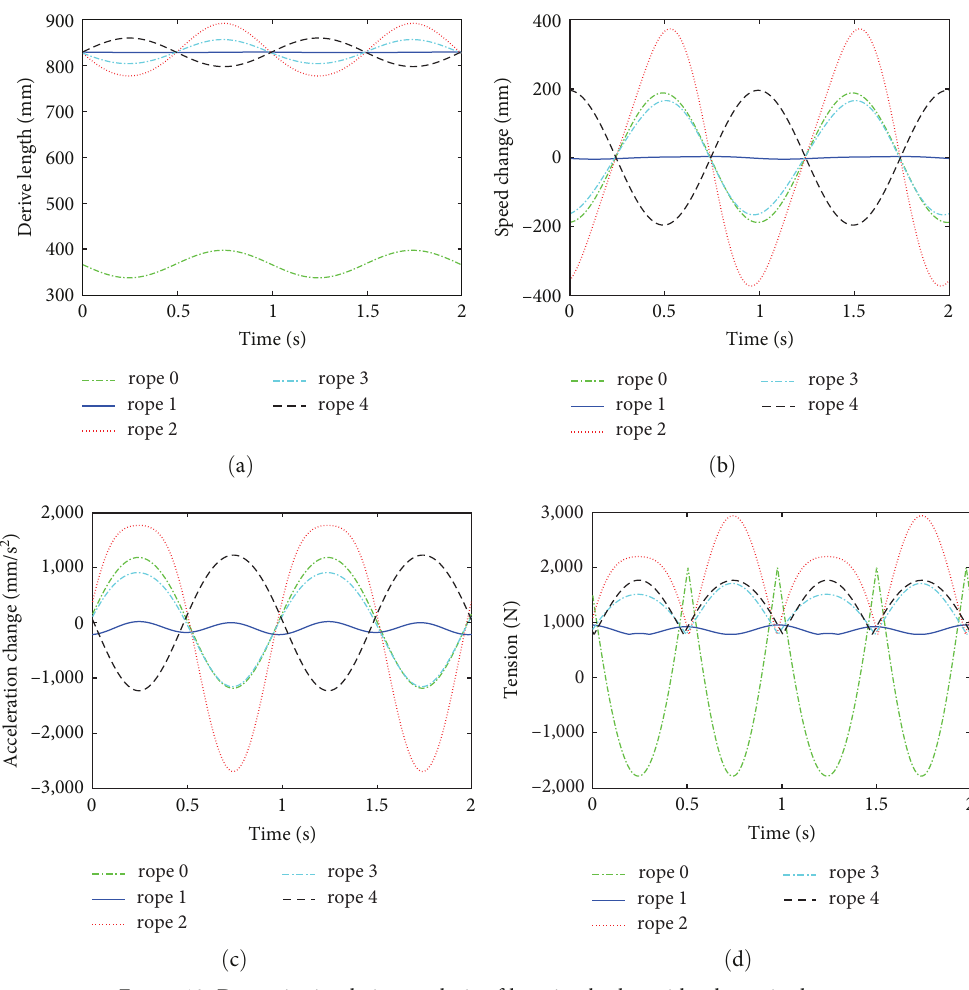
F IGURE 12: Dynamic simulation analysis of hanging basket with telescopic